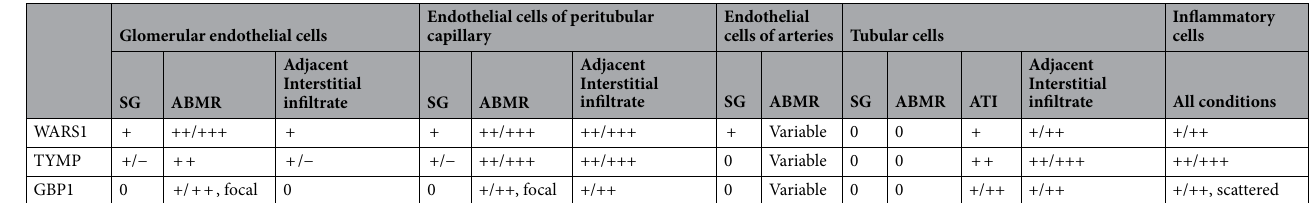
Table 4. Main observed expression patterns with the WARS1, TYMP and GBP1 antibodies in kidney allograft biopsies, with a focus on ABMR condition. The first line refers to the cell type where the staining is analyzed, while the second line refers to a condition. Interstitial infiltrate can notably refer to T cell-mediated rejection processes as well as infections. Please note that other cell types are sometimes also stained but are not displayed here as such stains appeared less consistent. Indeed, glomerular epithelial cells were sometimes stained with TYMP in ABMR, and also mesangial cells during glomerulitis lesions. ABMR Antibody-mediated rejection, SG Stable graft, ATI Acute tubular injury, WARS1 Tryptophan–tRNA ligase, cytoplasmic, TYMP Thymidine phosphorylase, GBP1 Guanylate-binding protein